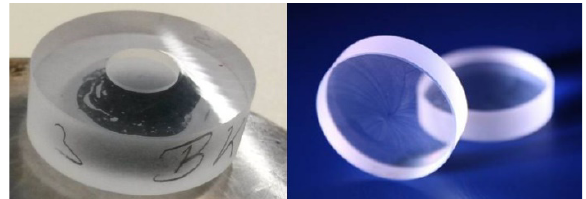
Fig. 5. Achieved surface qualities by ultra-fine face grinding